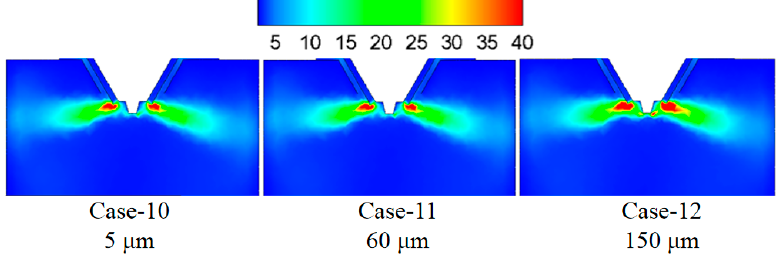
Figure 15. Effect of initial wastewater temperature on evaporation performance.